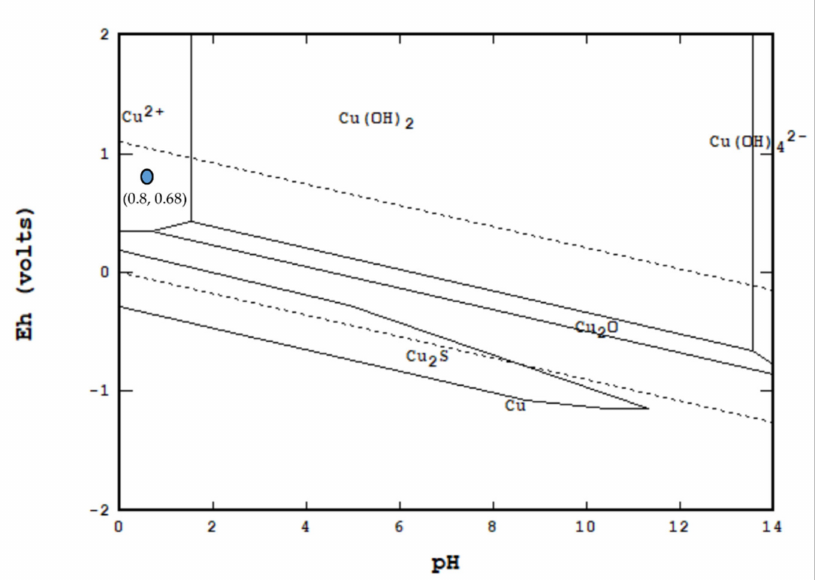
Figure 5. Eh − ph diagram for Cu − S − water system calculated by STABCAL (Condition: 180 ◦ C, 2 MPa).